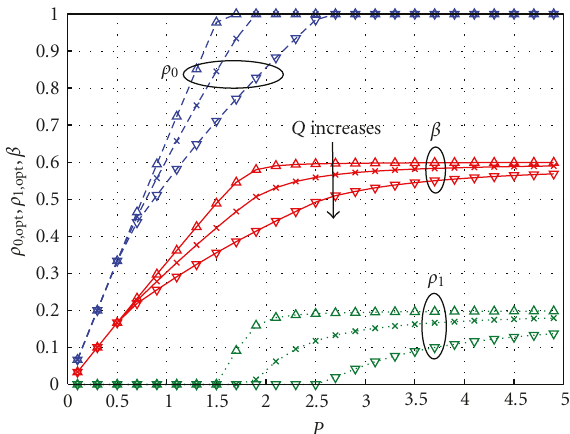
Figure 11: The optimal T opt under policy π 2 for di ff erent holding times.